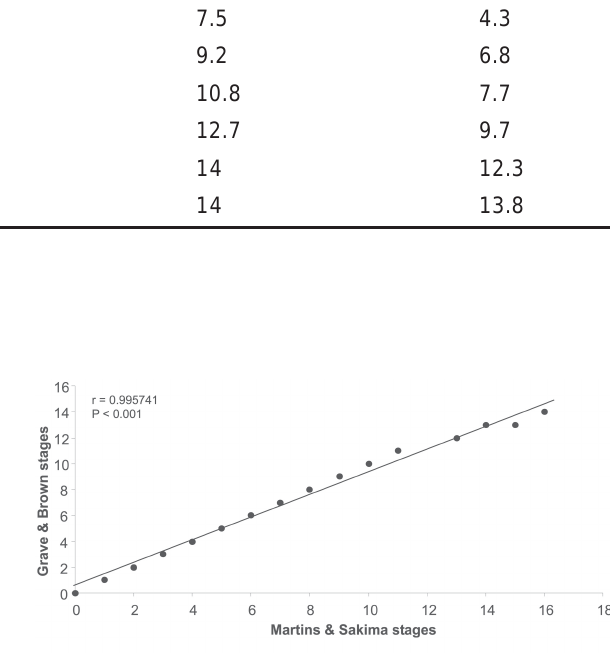
FIGURE 2- Graphic representation of the correlation between the puberal growth spurt predictions of Martins 14 and Grave and Brown 6 , for children with cleft lip and palate aged 7 to 17 years